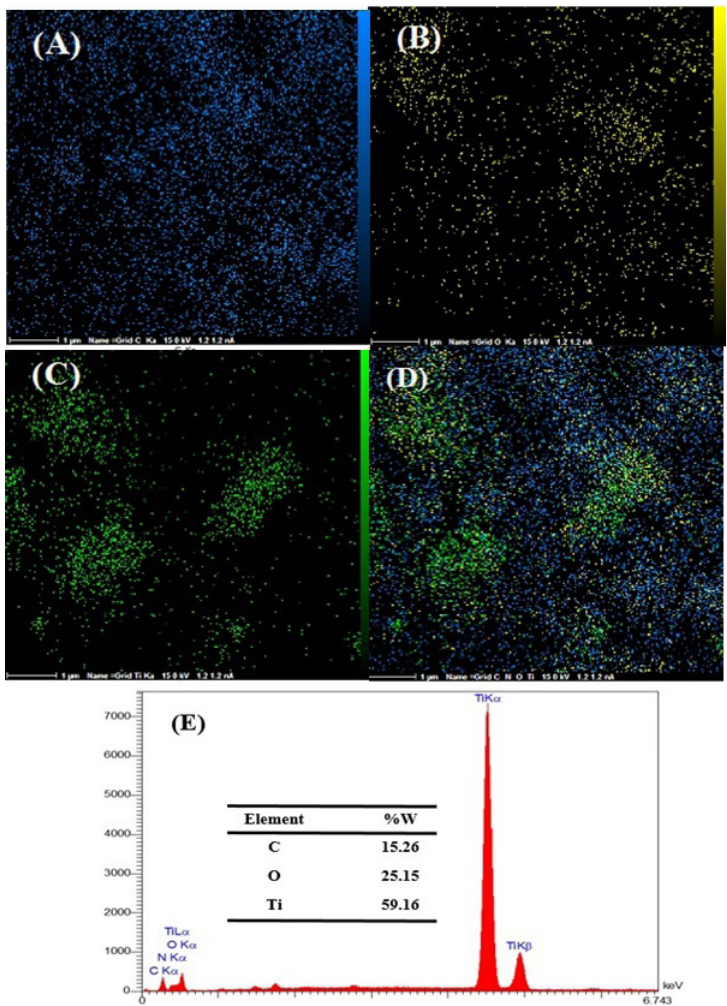
Fig. 2. EDX mapping of C (A), O (B), Ti (C), C, O, and Ti (D) and EDX spectra (E) of RGO/TiO